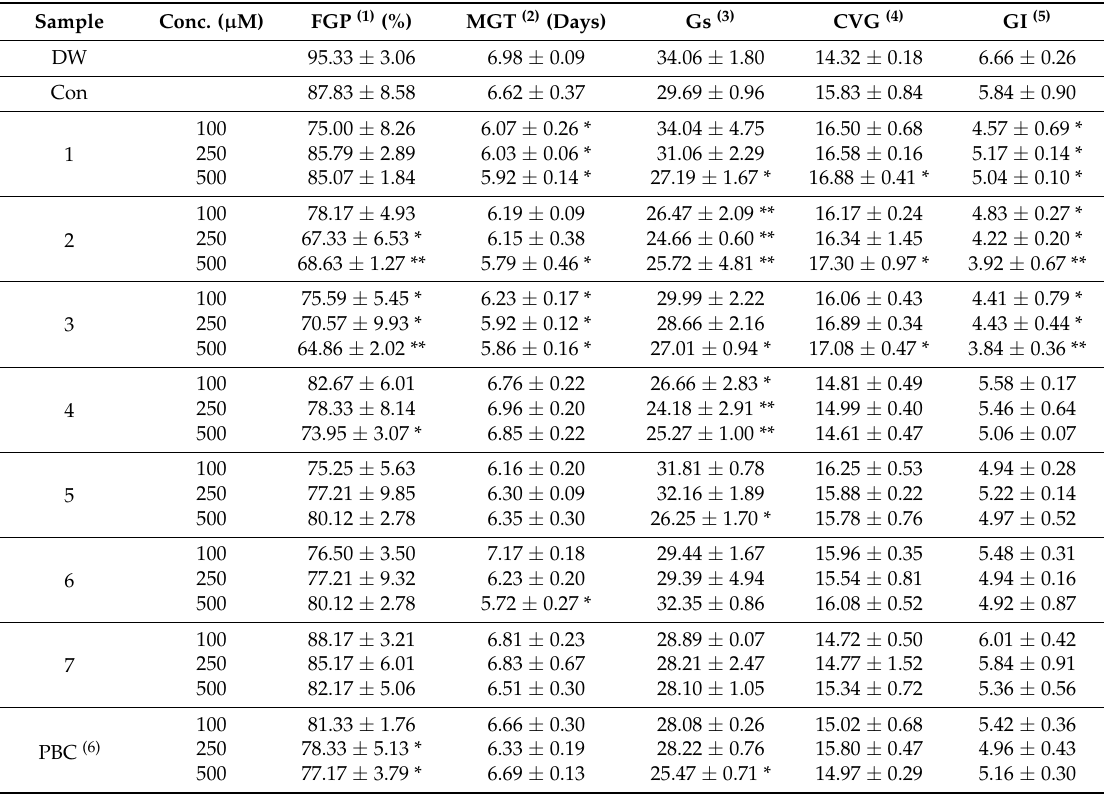
Table 5. Germination characteristics of E. oryzicola according to treatment of different concentrations of isolated compounds from rice ( O. sativa ) after 7